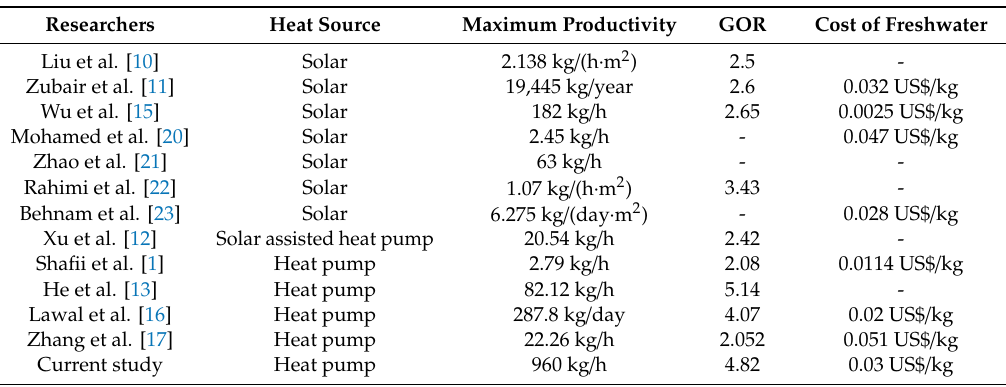
Table 2. Comparison of di ff erent systems.